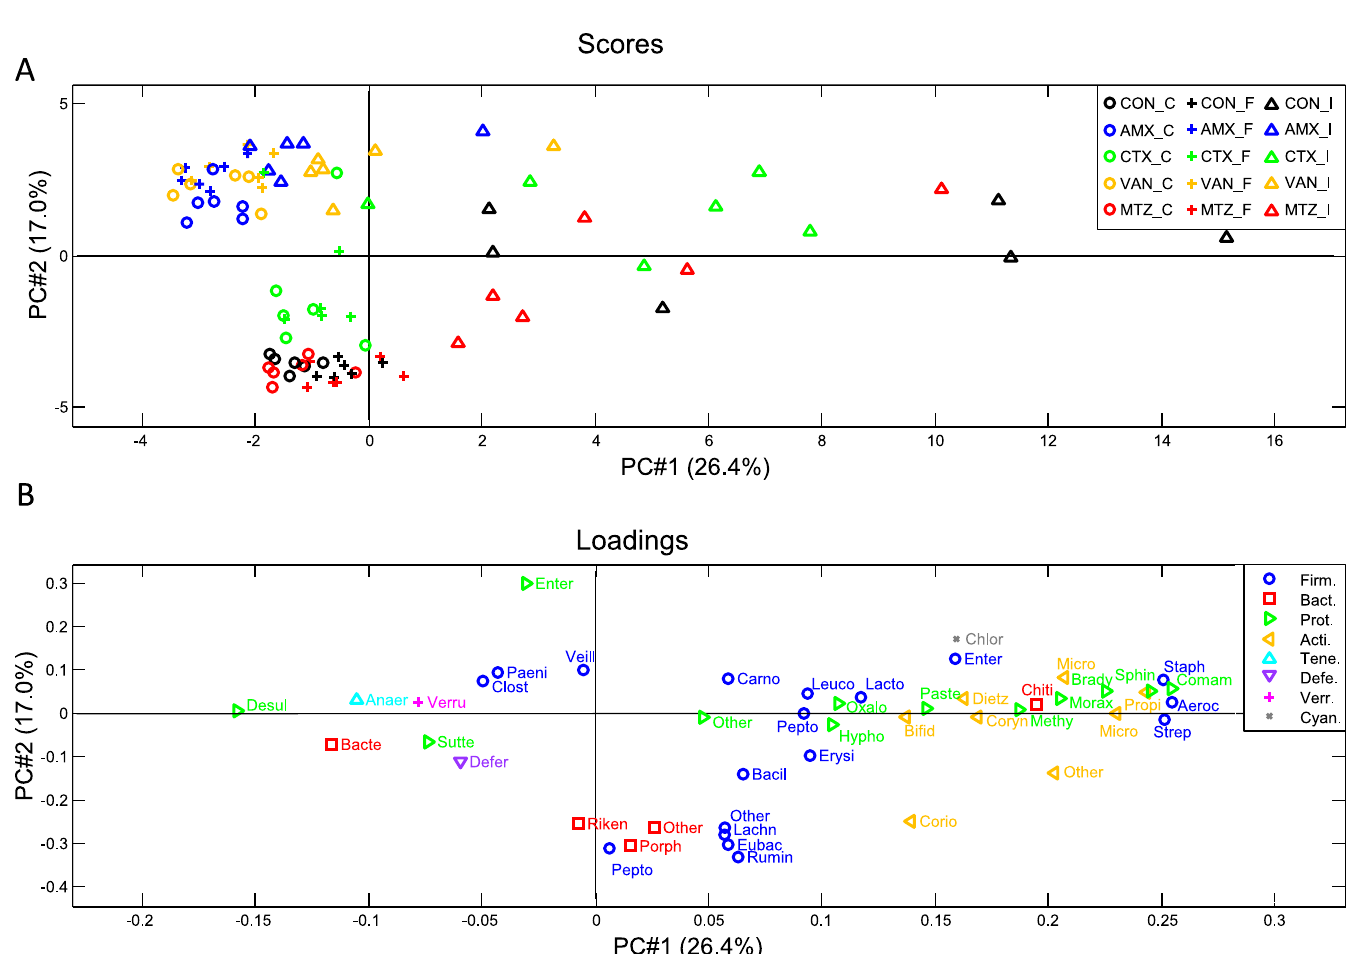
Fig 4. Principal component analysis (PCA) of the relative abundances of detected bacterial families in caecal, faecal and ileal samples. (A) Score plot showing samples grouped according to treatment groups CON (black), AMX (blue), CTX (green), VAN (yellow) and MTZ (red), with six animals in each group. (cid:4) Caecal samples; + Faeces samples and Δ Ilium samples. (B) Loading plot indicating each of the bacterial families colored according to phylum. Firm, Firmicutes (blue); Bact, Bacteroidetes (red); Prot, Proteobacteria (green), Acti, Actinobacteria (yellow); Tene, Tenericutes (light blue); Defe, Deferribacteres (purple); Verr, Verrucomicrobia (lilac) and Cyan, Cyanobacteria (grey).